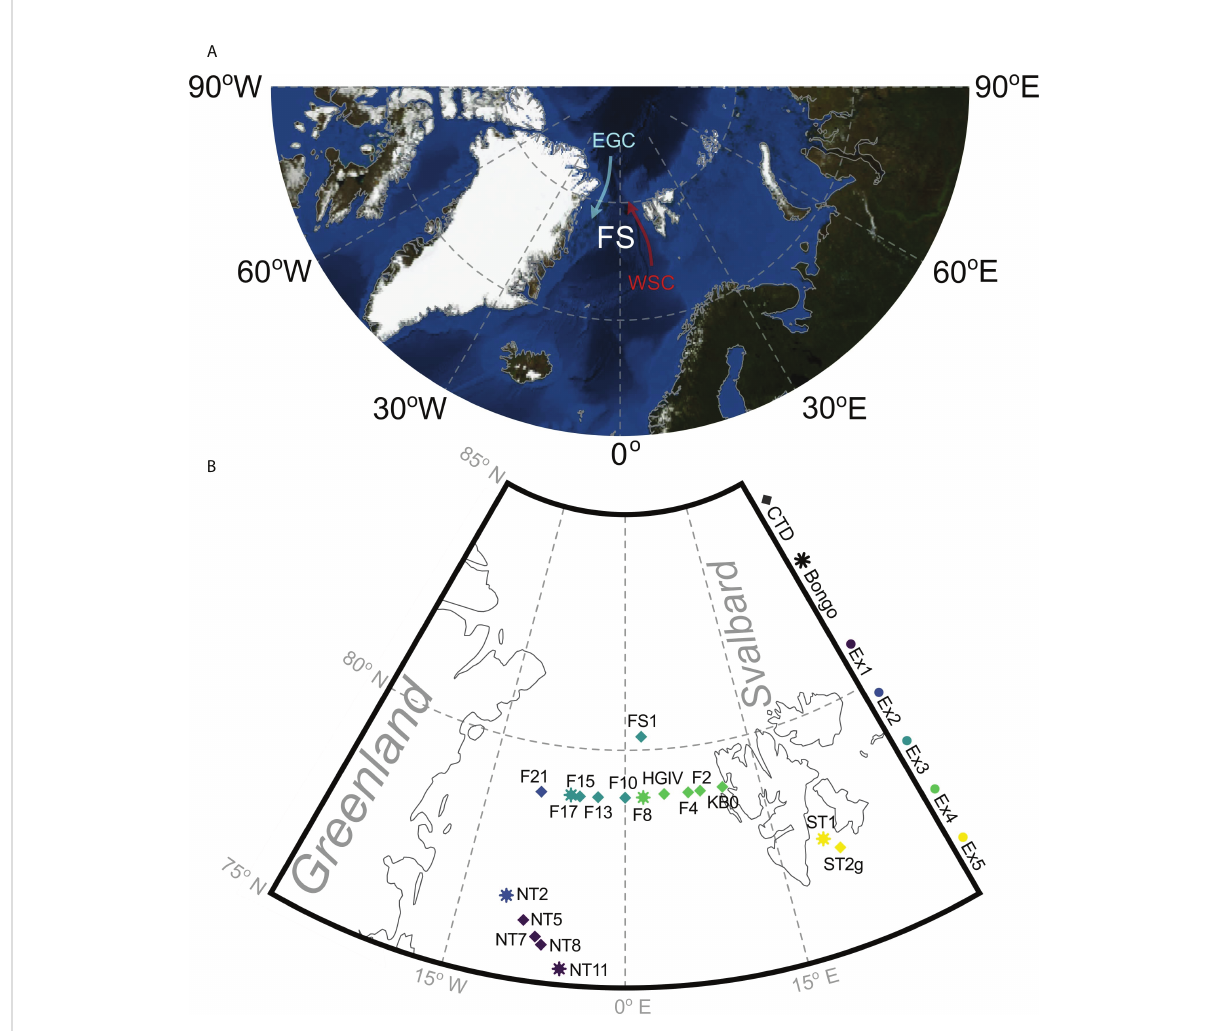
FIGURE 1 The location of the Fram Strait (FS) in the Arctic Ocean (A) and the stations that were sampled on cruise JR17005 in May-June 2018, showing the West Spitsbergen Current (WSC) and the East Greenland Current (EGC). Generated using Blue Marble, NASA Earth Observatory (B) . The Arctic Ocean map is coloured bathymetrically showing the deep channel of the Fram Strait, where most water enters and exits the Arctic Ocean. Sequential long-term grazing experiments (1-5) are marked by Ex1-Ex5. Bongo and CTD show the locations where animals for experimental incubations and the natural plankton assemblage were collected,